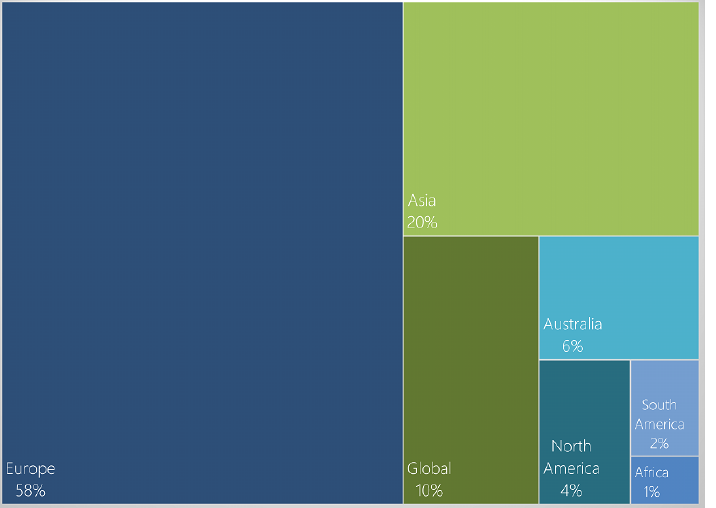
Figure 5. Regional focus of simulations dedicated to wave energy resource